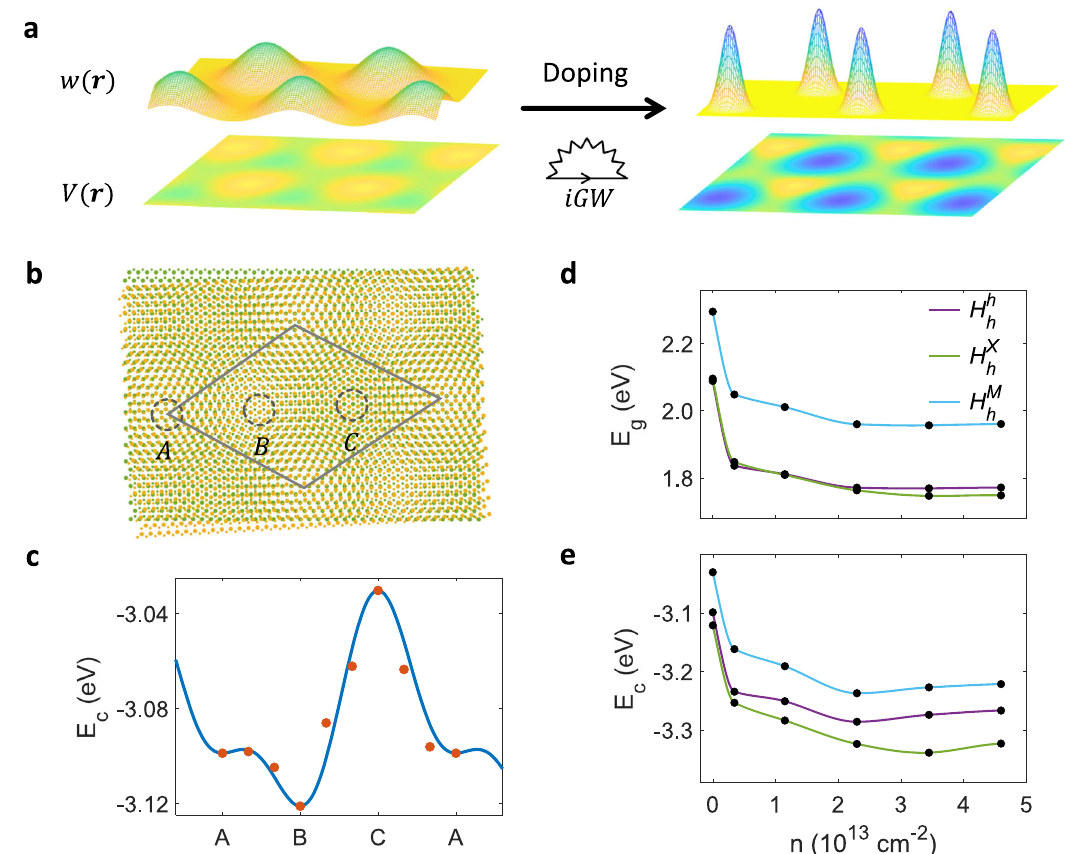
Fig. 1 Carrier plasmon-induced quasiparticle energy renormalization. a Schematic of doping-enhanced moiré potential in semiconducting vdW superlattices. V ( r ) and w ( r ) are the real-space moiré potential and wavefunction of quasielectrons, respectively. Under doping, the potential minimum drops due to inhomogeneous carrier distributions and QP energy renormalization. b Moiré superlattice formed by a twist between the H -type MoS 2 /WS 2 . The three high-symmetry stackings H h h , H X h , and H M h are labeled for simplicity as A , B , C , respectively. c Intrinsic moiré QP potential landscape along the three interlayer registries. The red dots represent fi rst-principles GW results. d Bandgap, and e CBM renormalization for the three interlayer registries of H type MoS 2 /WS 2 under electron doping. The dots are from many-body perturbation theory